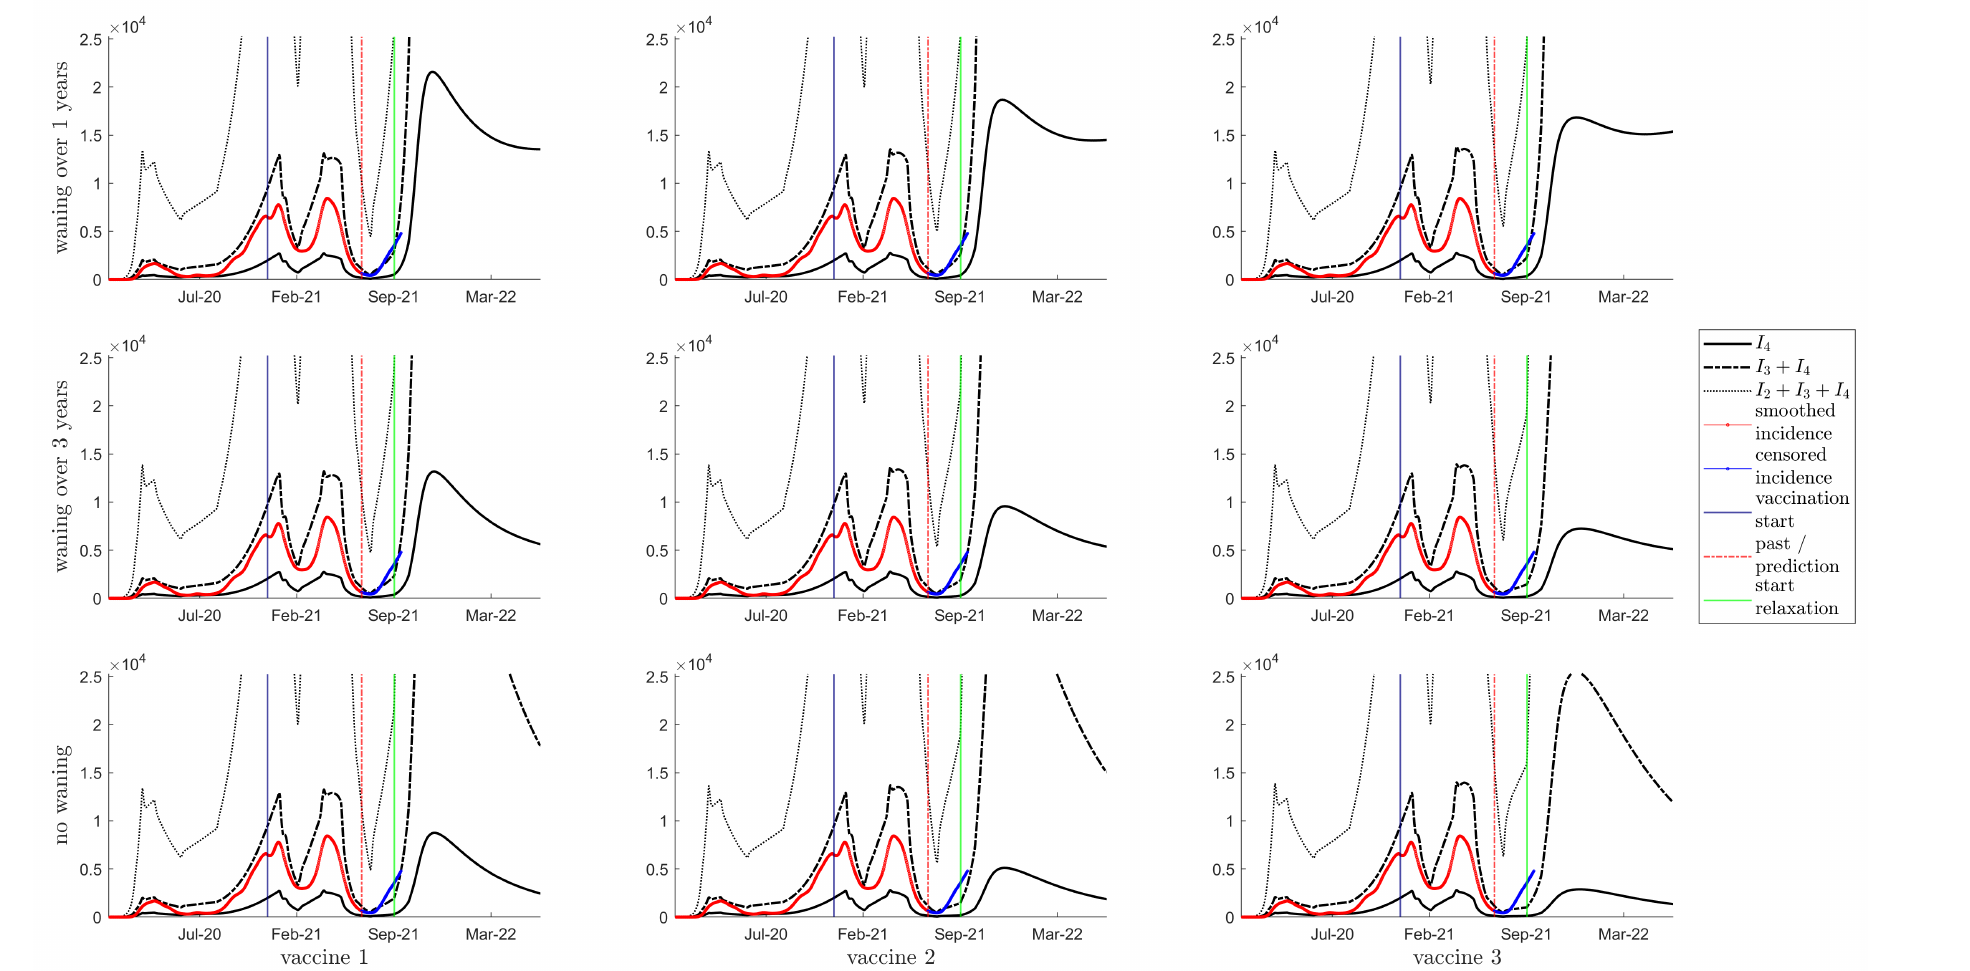
Figure 2. Daily Incidence, with a 20% relaxation of κ starting in September 2021. Showing daily incidence of I 4 (solid line), I 3 + I 4 (dashed line) and I 2 + I 3 + I 4 (dotted line). Smoothed incidence data is shown with a solid red line. The vertical blue, red and green lines indicate the start of vaccination, the beginning of the prediction phase, the start of relaxation, respectively. The top row is waning of immunity by one year between consecutive classes; the middle row is waning of immunity of three years; the bottom row is no waning of immunity. Columns left to right represent vaccines 1 to 3,